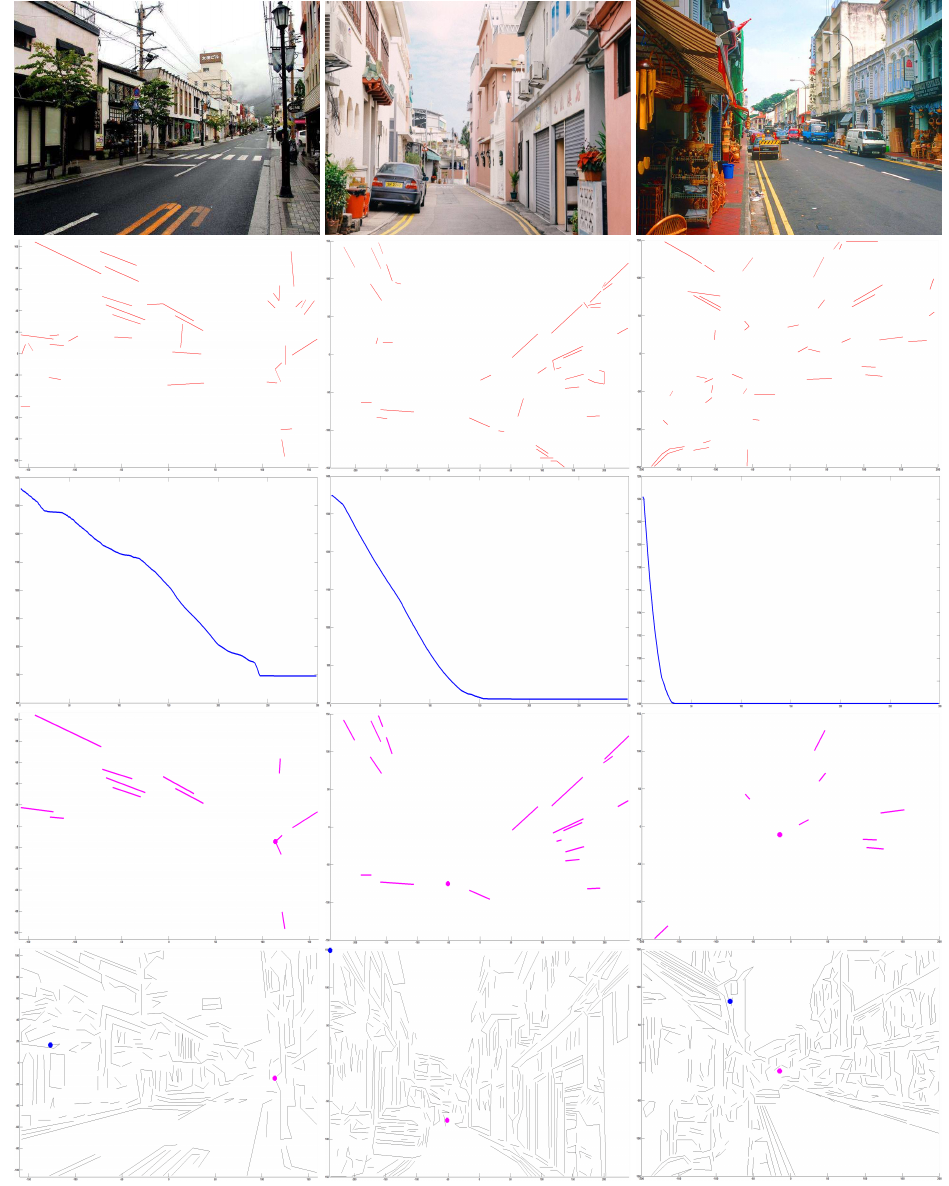
Figure 4. Experimental comparison. First row : input capture [3]. Second row : refined lines. Third row : convergence. Fourth row : optimal estimation. Bottom row : the blue point is the point estimated by H.W.’s method [3], and the pink point is the VP estimated by our method. It is obvious that our algorithm has better performance in estimating VP by refined